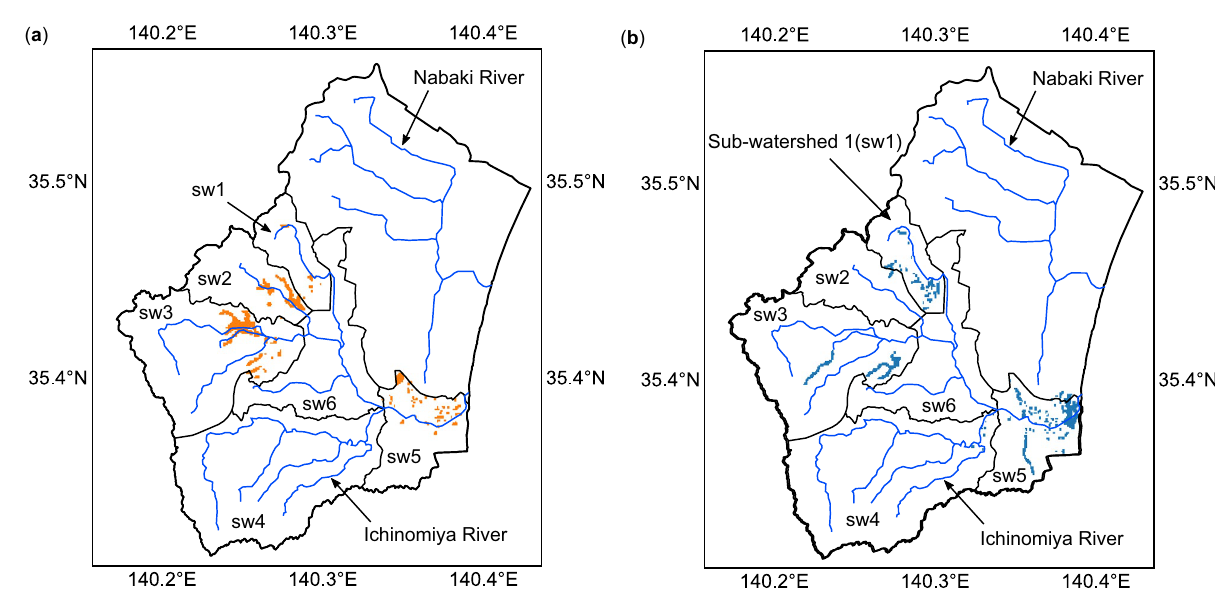
The calculated inundation areas in case 13P but not in 04A The calculated inundation areas in case 13A but not in 04P Figure 4. Comparison of the simulated inundation areas at the time of flood events in the year 2013 and 2004, respectively. ( a ) The difference of the calculated flooded areas between 04A and 13P, i.e., the area flooded by 13P but not by 04A. ( b ) The difference of the calculated flooded areas between 13A and 04P, i.e., the area flooded by 13A but not by 04P. (Figure generated using Matplotlib v. 2.2.3, http://www.matpl otlib